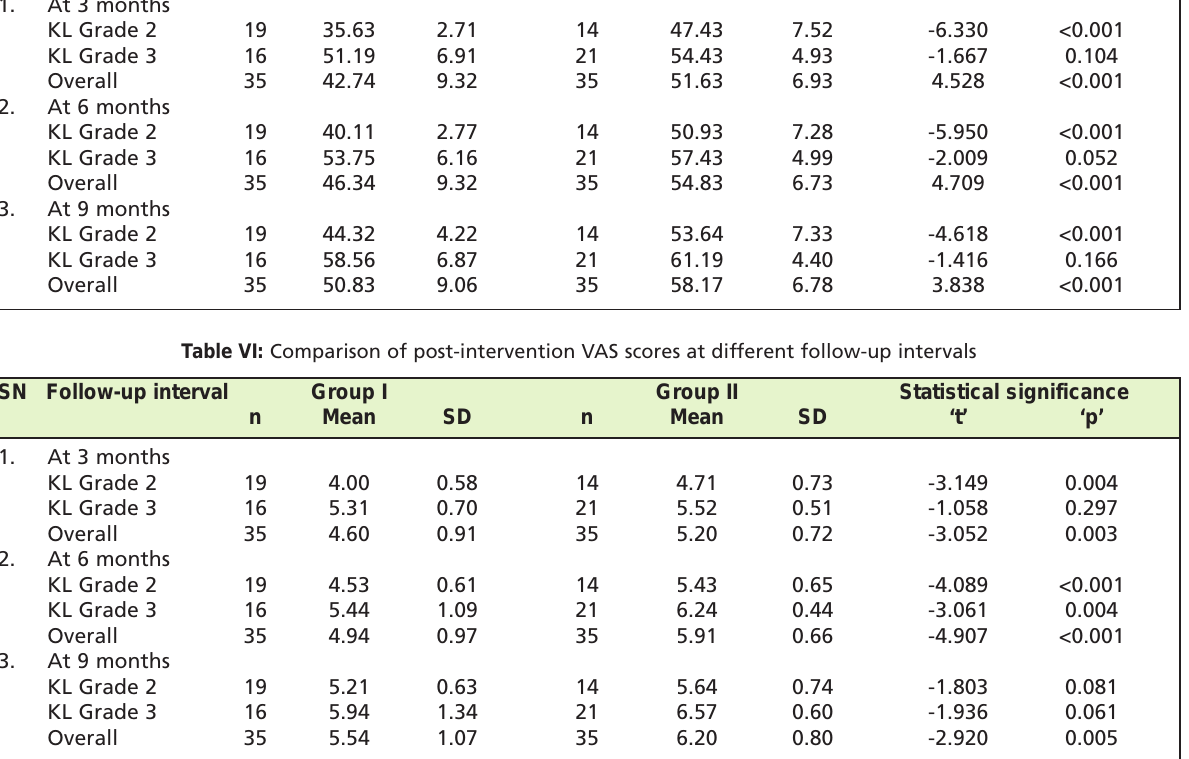
Comparison of percent reduction in WOMAC scores between two groups at different follow-up intervals Table VII: SN Follow-up interval Group I Group II